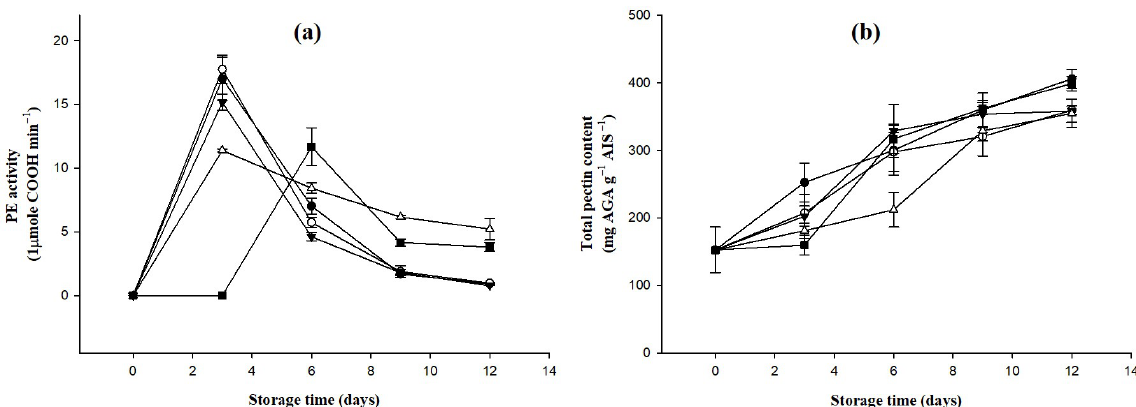
Figure 2. Effect on ( a ) weight loss, ( b ) firmness, ( c ) pH, and ( d ) titratable acidity (triplicate mean ± SD) of bananas coated with different concentrations of D-limonene nanoemulsion edible film and stored at 13 ± 1 °C from 0 to 12 days. ( ) control, ( ) 0%, ( ) 0.5%, ( ) 1.0%, and ( )